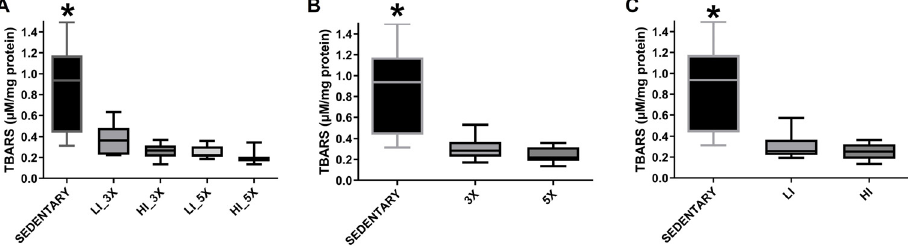
Figure 4. Median and interquartile range of thiobarbituric acid reactive substances (TBARS) level in renal tissue samples from groups (sedentary, trained at low [LI] and high [H]) intensity, three times [3X] and fi ve times [5X] per week) ( A ) and according to animals grouped by training frequency (three and fi ve times per week) ( B ) and training intensity (low and high intensity) ( C ). *P o 0.05 compared with all trained groups (Kruskal-Wallis).